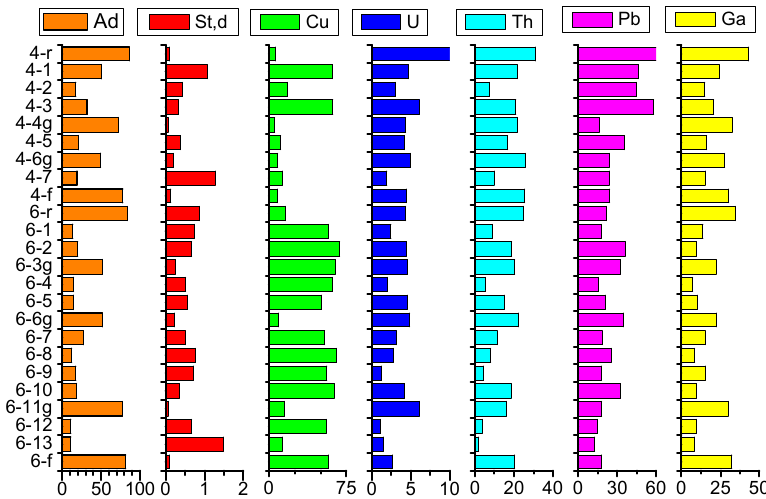
Figure 7. Variations of ash yield, total sulfur, Cu, U, Th, Pb, Ga in the coal beds of No. 4 and No. 6 coal. Distribution Pattern of Rare Earth Elements and